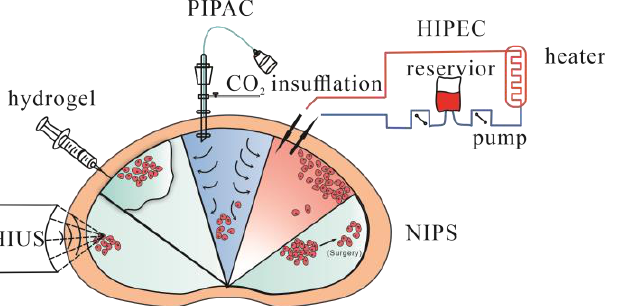
Figure 3. Treatments being applied to peritoneal metastasis. HIPEC = hyperthermic intraperitoneal chemotherapy. PIPAC = pressurized intraperitoneal aerosol chemotherapy. HIUS = high-intensity ultrasound. NIPS = neoadjuvant intraperitoneal and systemic chemotherapy. Hydrogel = using hydrogel as a delivery system for local regions.